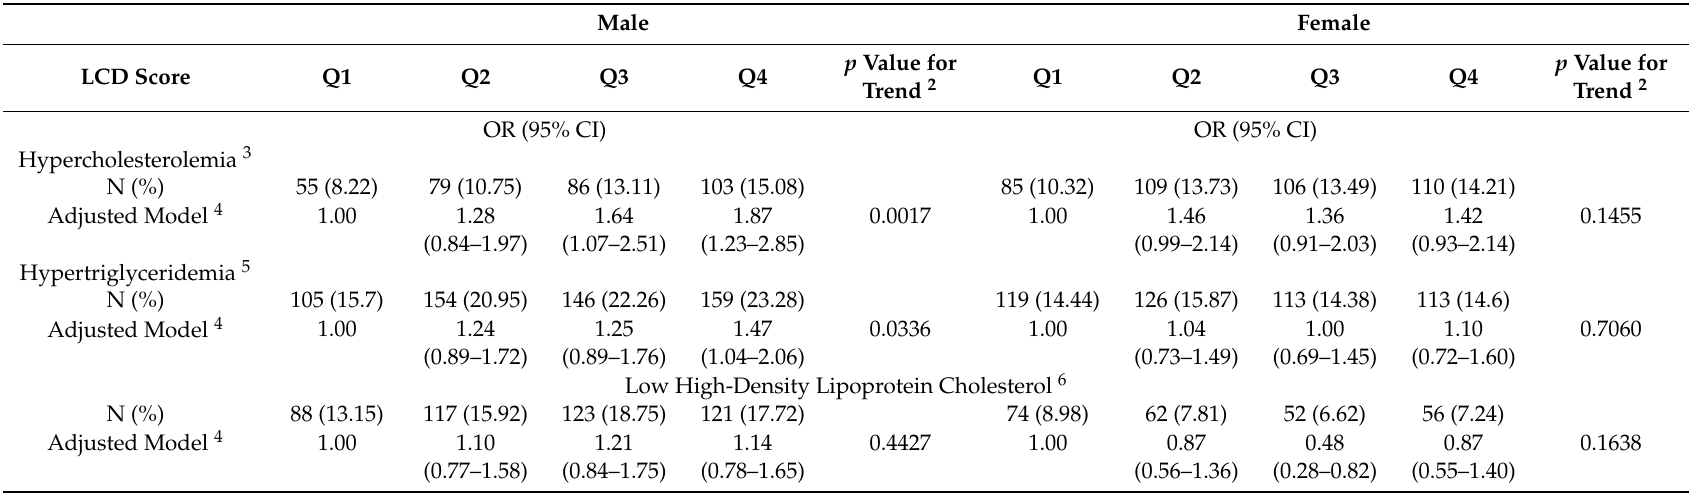
1 All statistical analyses accounted for the sampling design of the national surveys in the 2009 wave. Values are presented as n (%) or ORs (95%CIs). 2 p for trend values were calculated using the generalized linear model. 3 Hypercholesterolemia was defined as a total cholesterol level ≥ 6.22 mmol / L (240 mg / dL) on fasting blood glucose test, low-density lipoprotein cholesterol level ≥ 4.14 mmol / L (160 mg / dL). 4 Adjusted for age, educational level, body mass index, ethnicity, physical activity level, alcohol consumption, smoking status, and individual income. 5 Hypertriglyceridemia was defined as a triglyceride level ≥ 2.26 mmol / L (200 mg / dL). 6 A low high-density lipoprotein cholesterol (HDL-C) level was defined as a HDL-C level < 1.04 mmol / L (40 mg /